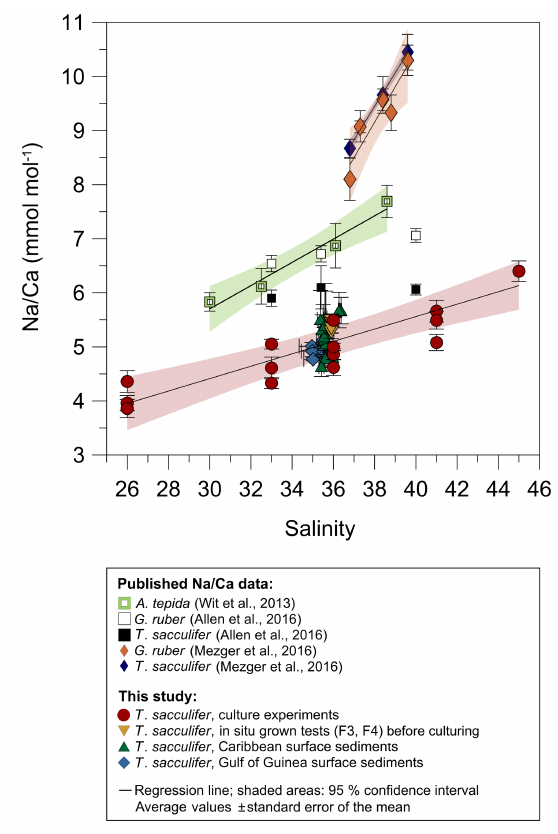
Figure 7. Comparison of foraminiferal Na / Ca values in response to salinity changes between this study’s T. sacculifer from cul- ture experiments and surface sediments with published Na / Ca data of benthic (Wit et al., 2013) and planktonic foraminifera (Allen et al., 2016; Mezger et al., 2016). All Na / Ca values are average values from 25–40 specimens per analysis, except for our culture experiments. Here, each red and yellow sym- bol represents average Na / Ca values of one foraminifer. Solid lines mark the regression of averaged values and shaded areas define the 95% confidence interval for each study. Regression lines are based on the following equations: Wit et al. (2013): Na / Ca A. tepida = 0 . 22 · S − 0 . 75 ( R 2 = 0 . 96, p < 0 . 01); Allen et al. (2016): Na / Ca G. ruber ( pink ) = 0 . 074 ( ± 0 . 006 ) · S + 4 . 1 ( ± 0 . 2 ) , ( R = 0 . 99, p < 0 . 01), no significant relationship of Na / Ca with salinity in T. sacculifer ; Mezger et al. (2016): Na / Ca G. ruber ( w ) = 0 . 57 · S − 12 . 38 ( R 2 = 0 . 91, p < 0 . 001); Na / Ca T. sacculifer = 0 . 60 · S − 13 . 49 ( R 2 = 0 . 99, p < 0 . 001); Our study: Na / Ca T. sacculifer = 0 . 97 + 0 . 115 · salinity ( R = 0 . 97, p < 0 . 005). Vertical error bars are based on the standard error of the mean and horizontal error bars of surface sediments (as big as the symbols for Caribbean sam- ples) demonstrate the salinity gradient between 0 and 60m of water depth, the possible habitat range of T. sacculifer . Different regres- sion lines for the same species, e.g., T. sacculifer , demonstrate var- ious potential factors, and not only salinity, controlling Na incorpo- ration in foraminiferal calcite (discussed in Sect. 4.3). However, our results of culture experiments correspond to fossil samples of sur- face sediments from two regions, suggesting this regression is the most reliable for